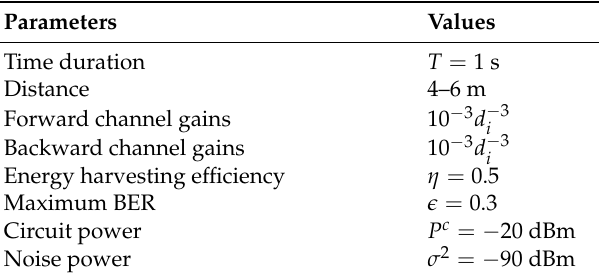
Table 1. Simulation parameters.